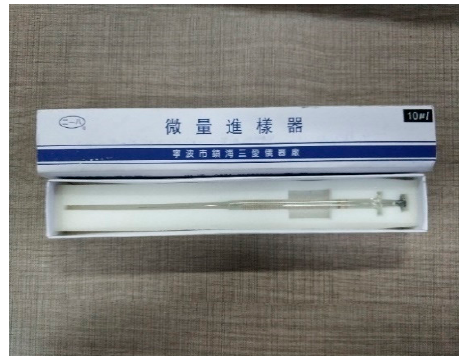
Figure 4. Micro sampler.